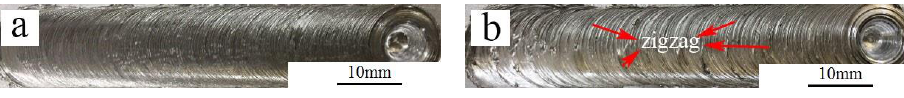
Figure 1. Surface morphologies of weld with AS: ( a ) Mg, ( b ) Al.